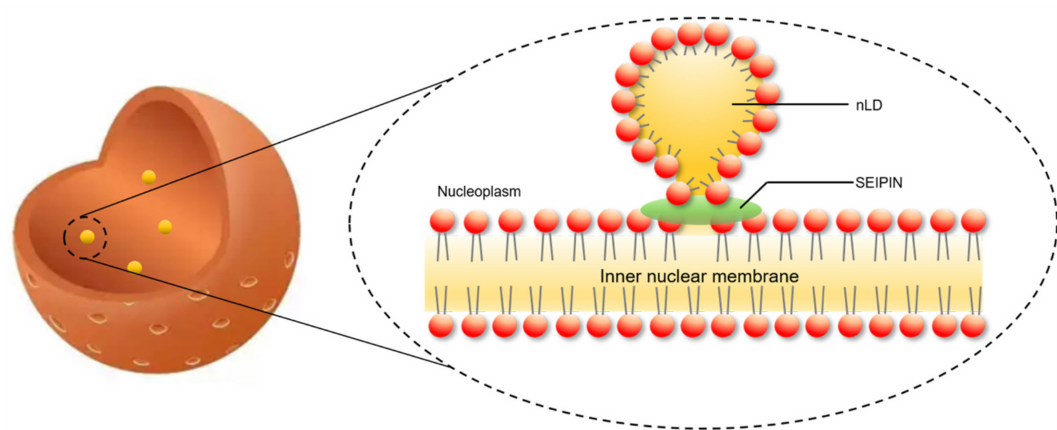
Figure 3. SEIPIN is involved in nuclear lipid droplets generation. SEIPIN mediated the generation of a lipidic bridge, which connects the nascent nLD and the inner nuclear membrane.